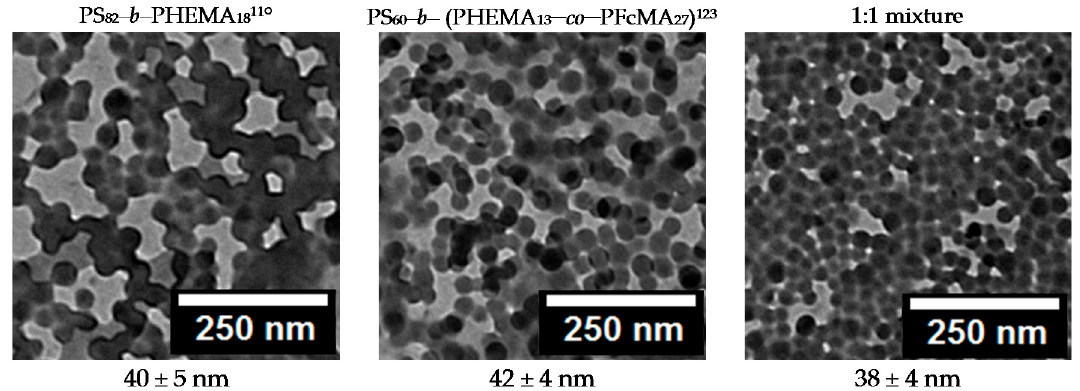
Figure 4. TEM images of block copolymer micelles of PS 82 – b –PHEMA 18110 , ferrocene functionalized PS 60 – b –(PHEMA 13 – co –PFcMA 27 ) 123 and a 1:1 wt % mixture of the block copolymers. The used solvent system was THF/DMF/DOX 2:1:1 wt